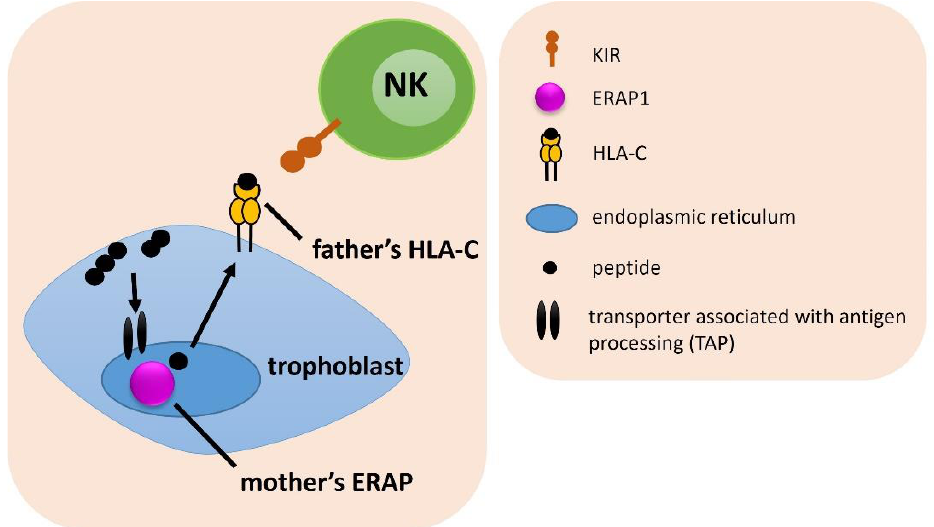
Figure 2 . The influence of female ERAP and male HLA-C on embryo implantation. The arrows indi- cate the successive stages of the formation of antigenic peptides.